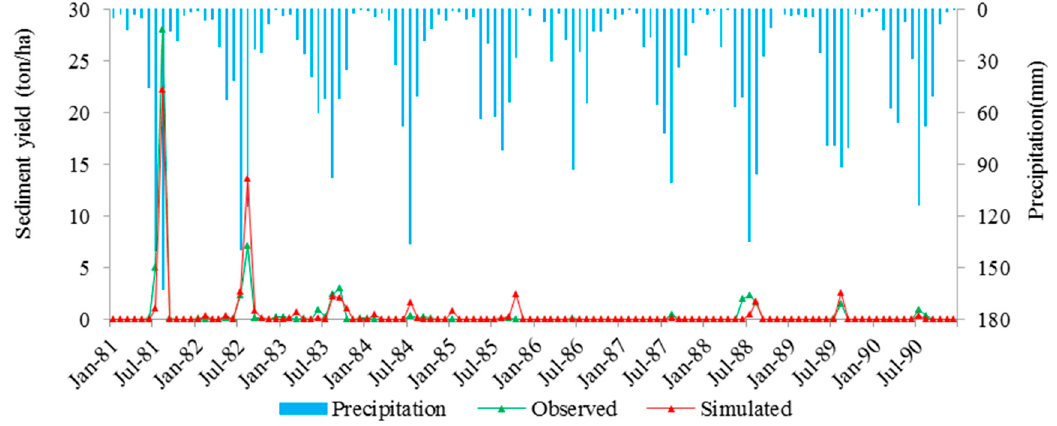
Figure 6. The observed and simulated sediment yield under Scenario 0 in the USK river basin.